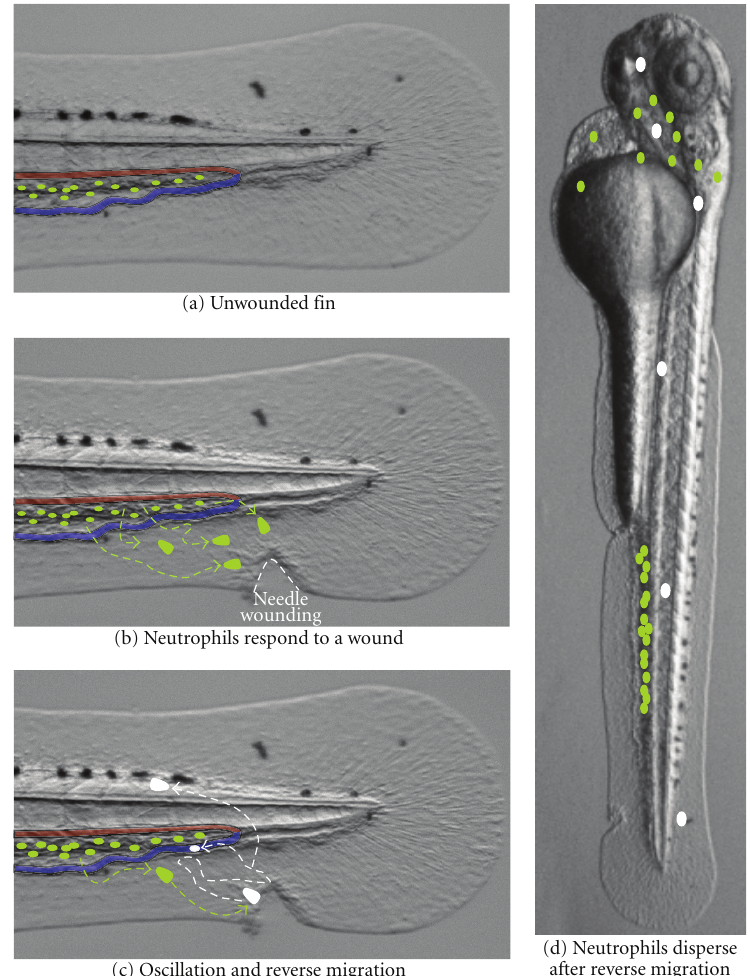
Figure 1: Neutrophil reverse migration in zebrafish larvae. This diagram illustrates the behavior of neutrophils undergoing reverse migration over an image of a 3-day postfertilization zebrafish larva that was PTU-treated to prevent pigmentation. (a) In unwounded larva, neutrophils (green ovals) are present in the caudal hematopoietic tissue (CHT), which is situated between the caudal artery (red shading) and the caudal vein (blue shading). (b) In response to a wound, neutrophils are mobilized from the CHT, and they migrate through the tissue towards a wound. (c) The green to white color change represents the ability to photoconvert individual neutrophils that reach a wound. Neutrophils often migrate between the wound and the vasculature multiple times before finally departing. Neutrophils have been observed performing reverse migration by entering the vasculature and by migrating through tissues in zebrafish larvae. (d) Reverse migrated neutrophils (white) are found dispersed throughout the body without an obvious tissue preference 2 days after leaving